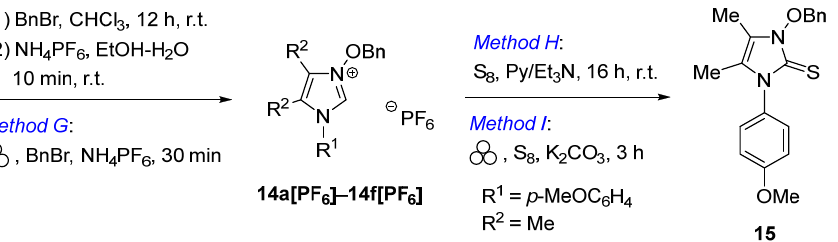
Table 2. Synthesis of alkoxy-imidazolium salts of type 14[PF 6 ] and the sulfurization of 14c[PF 6 ] ; comparison of mechanochemical ( Methods G and I ) approaches with reactions in solution ( Methods F and H ) a